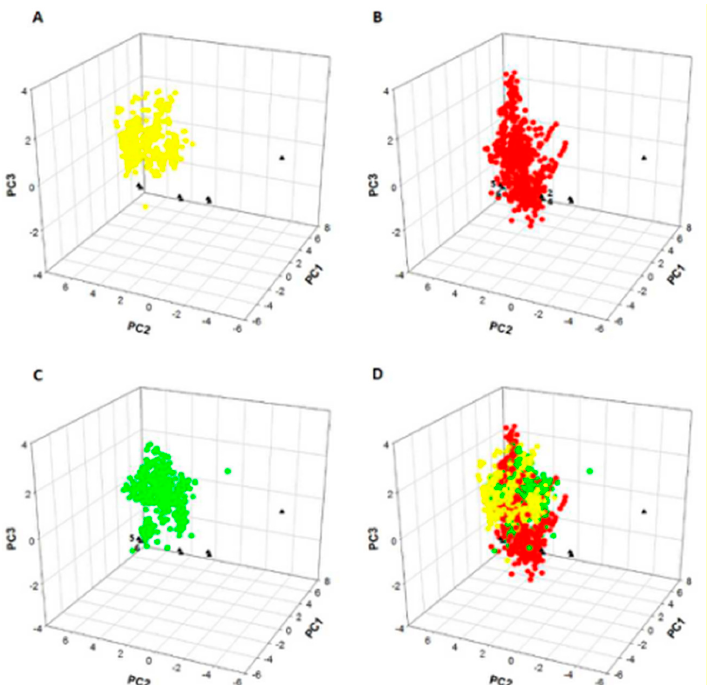
Figure 6. ChemGPS-NP analysis of seven chemical ingredients from the licorice aqueous extract. Score plot of the three dimensions consisting of PC1, PC2 and PC3 from analysis of seven ingredients from licorice aqueous extract: ( 1 ) liquiritin apioside; ( 2 ) liquiritin; ( 3 ) isoliquiritin apioside; ( 4 ) isoliquiritin; ( 5 ) liquiritigenin; ( 6 ) isoliquiritigenin and ( 7 ) glycyrrhetinic acid as black triangles with a reference set of known inhibitors targeting p38 (yellow), MK2 (red) and PKC (green) in the ChemGPS-NP model. ( A ) The seven chemical ingredients (black triangles) were positioned in the resulting map of known p38 inhibitors (yellow); ( B ) The seven chemical ingredients (black triangles) were positioned in the resulting map of known MK2 inhibitors (red); ( C ) The seven chemical ingredients (black triangles) were positioned in the resulting map of known PKC inhibitors (green); ( D ) The seven chemical ingredients (black triangles) were positioned in the resulting map of known p38 (yellow), MK2 (red) and PKC (green) inhibitors.